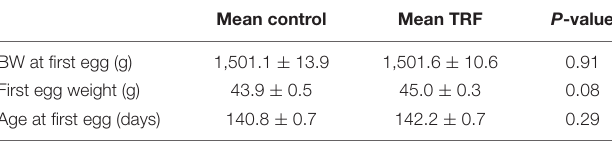
TABLE 1 | Measures of entry to lay of the two groups before TRF